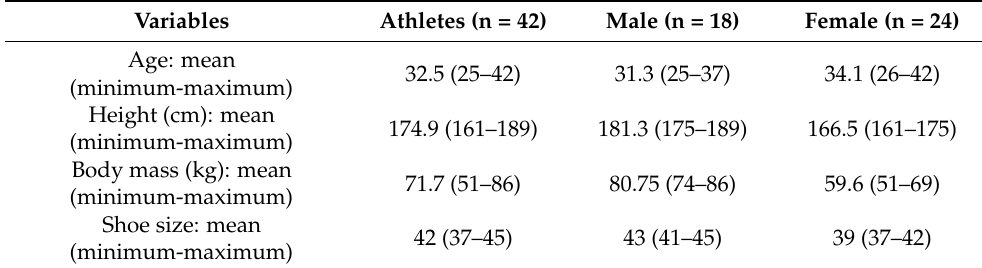
Table 1. Mean ± SD of anthropometric and demographic data features of CrossFit Athletes.